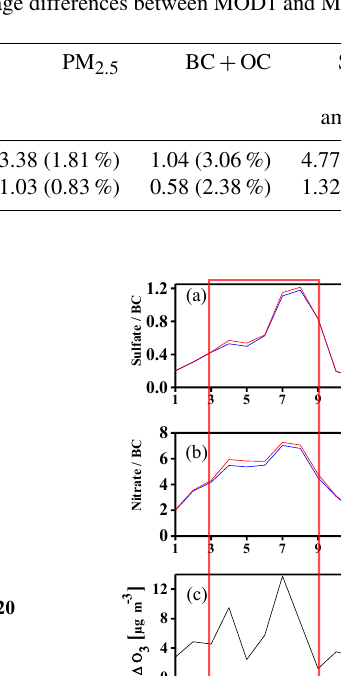
Figure 6. Ratios of HCHO / NO y simulated in MOD1 (blue) and MOD2 (red).